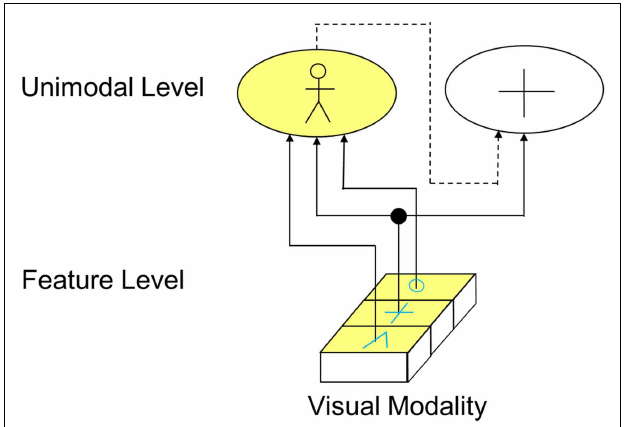
FIGURE 6 | Function of feedback connections (solid lines indicated excitatory connections, dotted lines indicate inhibitory connections).